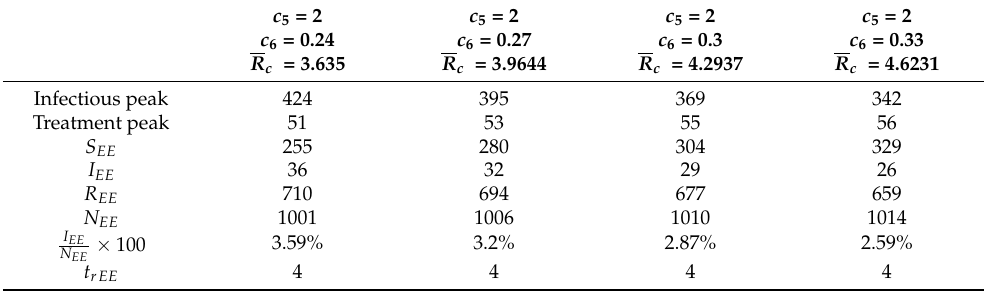
Table 4. Specifications of the model behaviour for the four considered pairs of values of the control parameters c 5 and c 6 governing the treatment